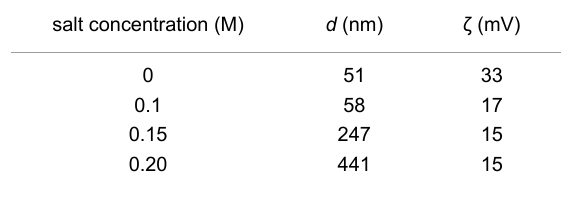
Table 1: Hydrodynamic diameters, d , and zeta potentials, ζ , measured by DLS of SNPs prepared at increasing salt concentrations (0–0.2 M NaCl) using CD-PEI and Fc 8 -PAMAM keeping the total concentration constant at [CD] = 100 µM and [Fc] = 50 µM (in Fc and CD moieties from Fc 8 -PAMAM and CD-PEI,